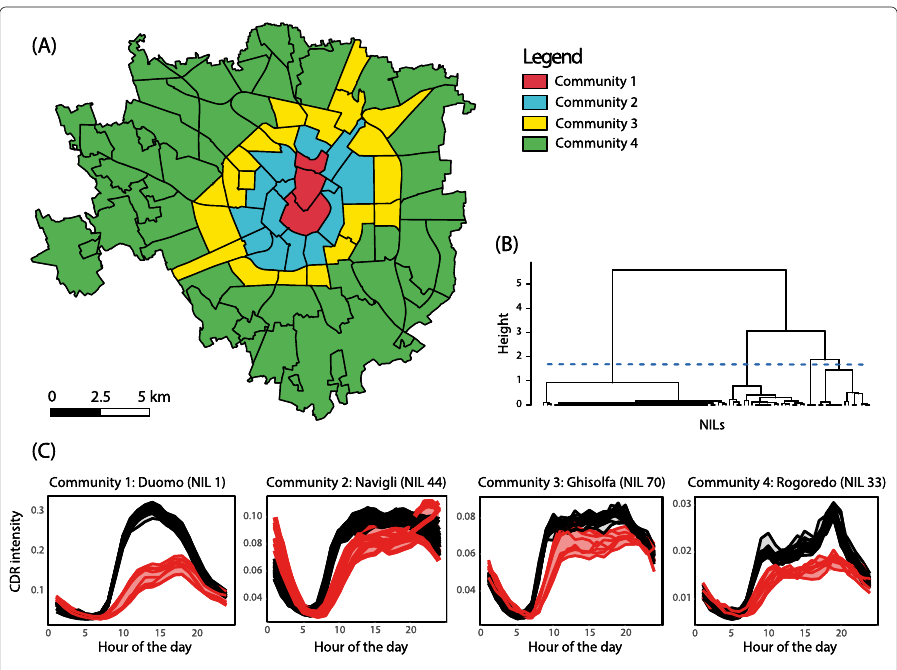
Fig. 4 Community detection based on CDRs. a Communities of NILs obtained using agglomerative hierarchical cluster analysis on the CDR data. b Dendrogram of the clustering procedure (see text). c Daily trends of CDR intensity (which we considered as a proxy of human use) in four NILs selected as representative of the four Communities shown in ( a ). Black and red lines represents trends in weekdays and weekends,